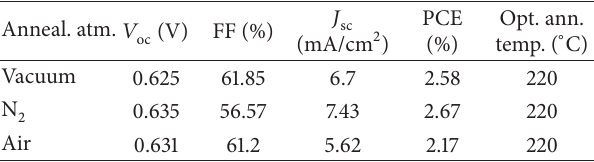
Table 1: Average photovoltaic properties of PH500 in different atmospheres at optimum annealing